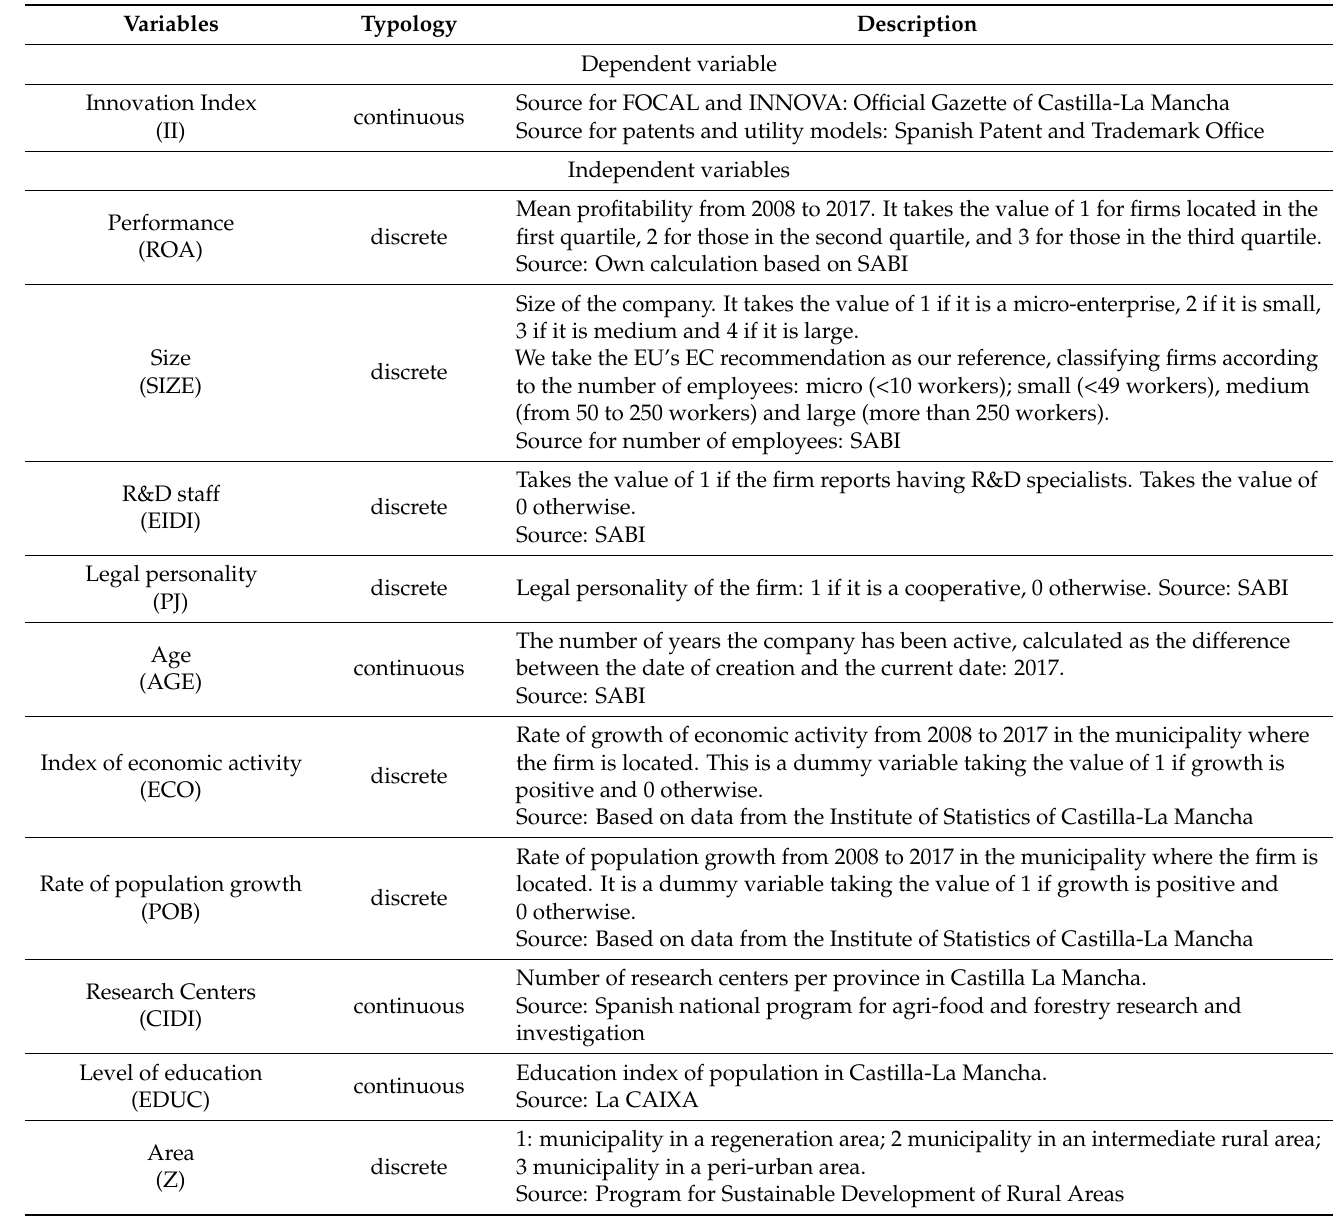
Table 1. Definition of the dependent and independent variables.